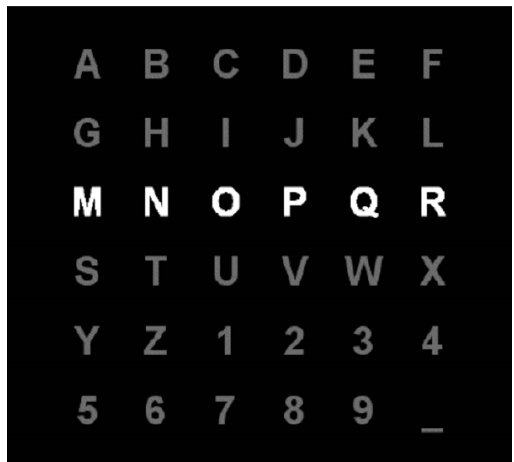
Figure 1. P300-speller interface of Dataset I.